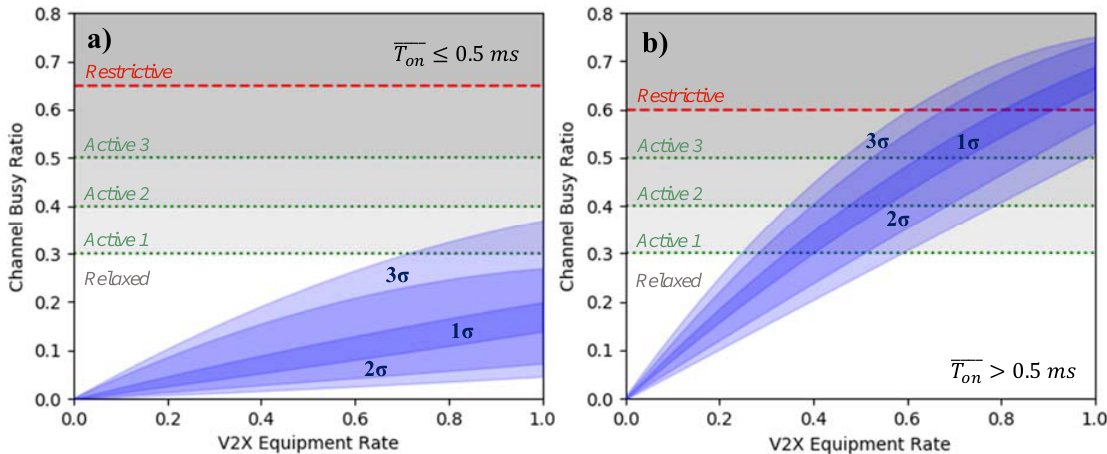
Figure 9. Channel busy ratio for ( a ) the low-density scenario and ( b ) the high-density scenario providing the 1, 2, and 3-standard deviation intervals. The figure further shows the DCC levels of the 5-state ETSI DCC for message durations ( a ) T on ≤ 0.5 ms and ( b ) T on > 0.5 ms [48] .